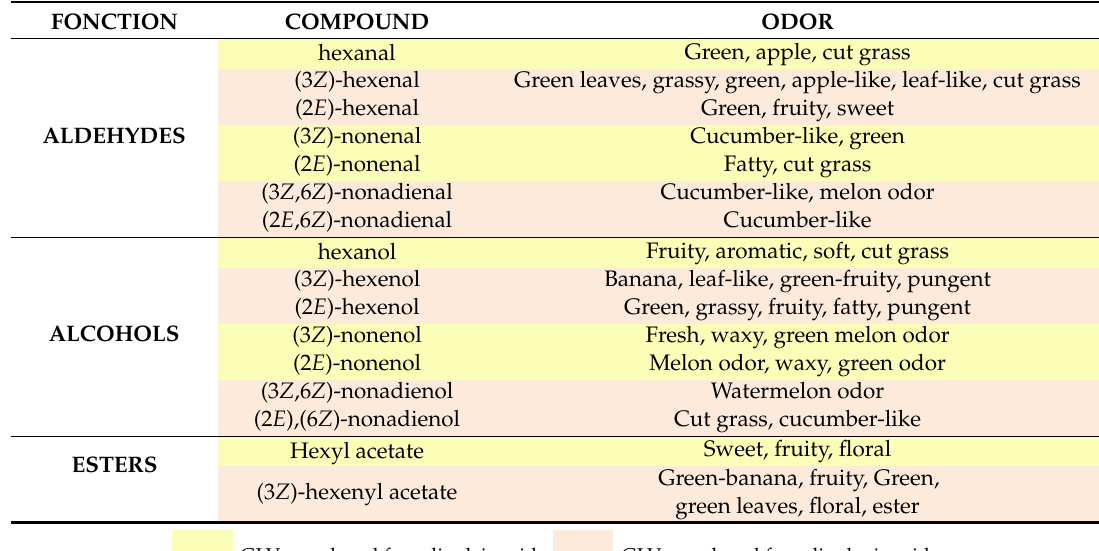
Table 1. Odor qualities attributed to green leaf volatiles (GLVs) formed by the lipoxygenase pathway. FONCTION